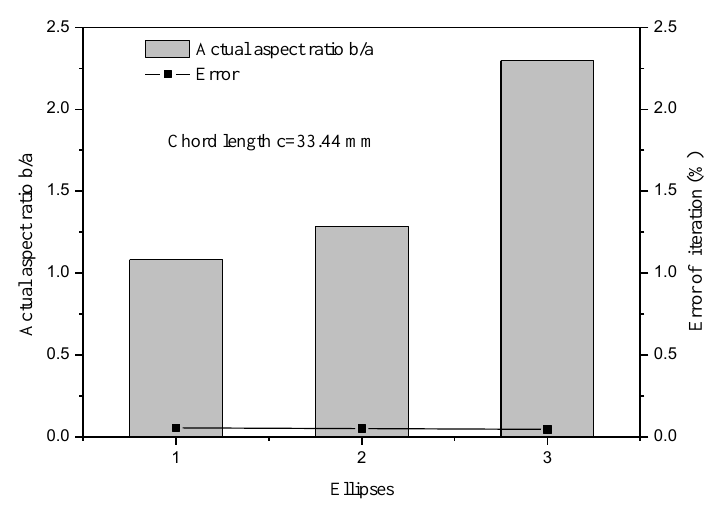
Figure 7. Change of actual aspect ratio with the same chord length 𝑐 .